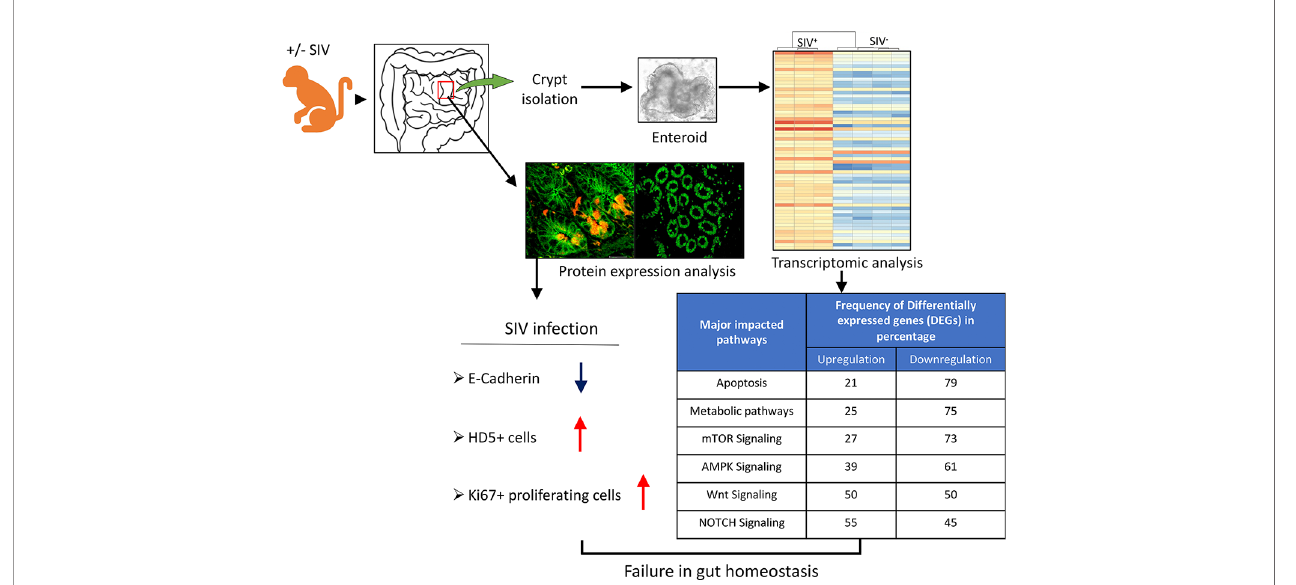
FIGURE 7 | Schematic representation of the main fi ndings. Jejunum tissues from SIV-infected and uninfected RhMs were collected. Tissues were either used for protein expression analysis by immunohistochemistry or immuno fl uorescence or used for crypt isolation for the growth of enteroids and their subsequent characterization and transcriptomic analysis. The protein expression analysis revealed signi fi cantly reduced E-cadherin expression indicative of the impairment of intestinal barrier function. In contrast, a signi fi cantly increased proliferation of epithelial cells was detected in both acute and chronic SIV-infected RhMs , possibly re fl ecting enhanced transit amplifying cell divisions. A signi fi cant increase in HD5+ Paneth cells during acute and chronic stages of SIV infection suggest a compensatory role of these cells in regulating mucosal immunity and effector mucosal function. Transcriptomic analysis showed DEGs involved in different biological pathways necessary for maintaining homeostasis, proliferation, and differentiation of intestinal epithelial cells in enteroids from SIV-infected RhMs when compared to SIV-uninfected control RhMs . Some of the important pathways and the frequency of upregulated and downregulated differentially expressed genes are shown for enteroids isolated from SIV-infected RhMs